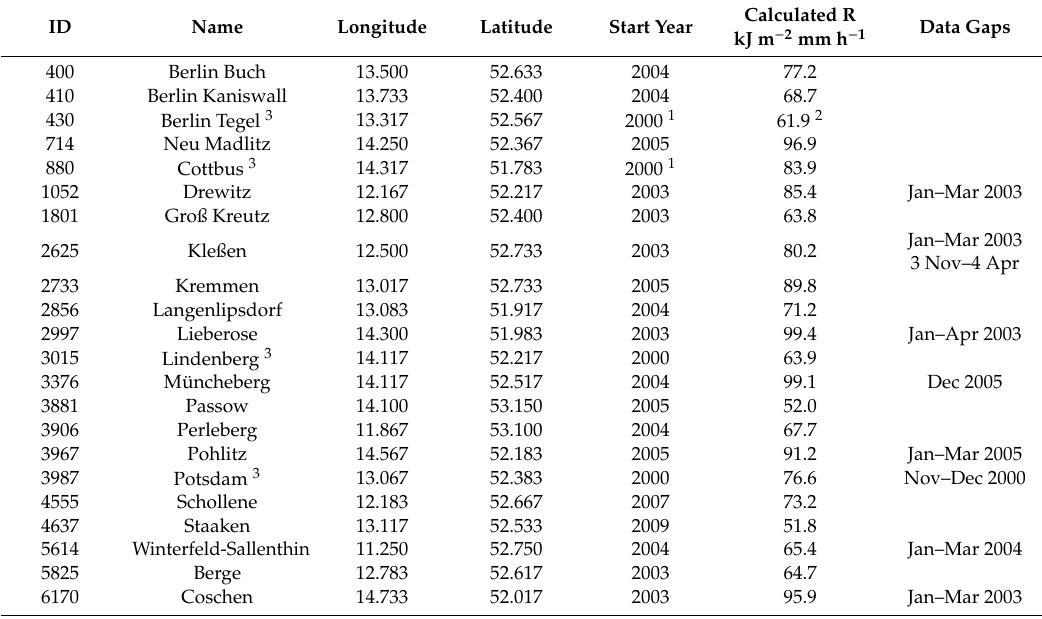
Table 1. Stations with high-resolution data for which R factors were calculated (end year is